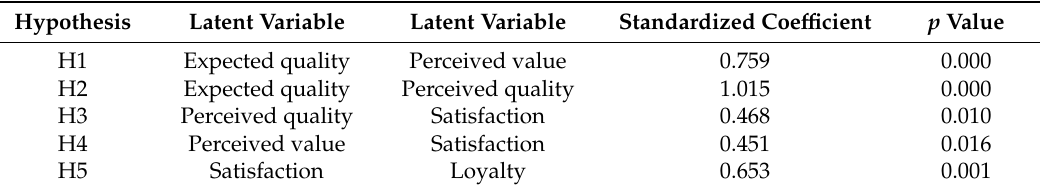
Table 3. Standardized coe ffi cients and p -values that support the hypothesis.